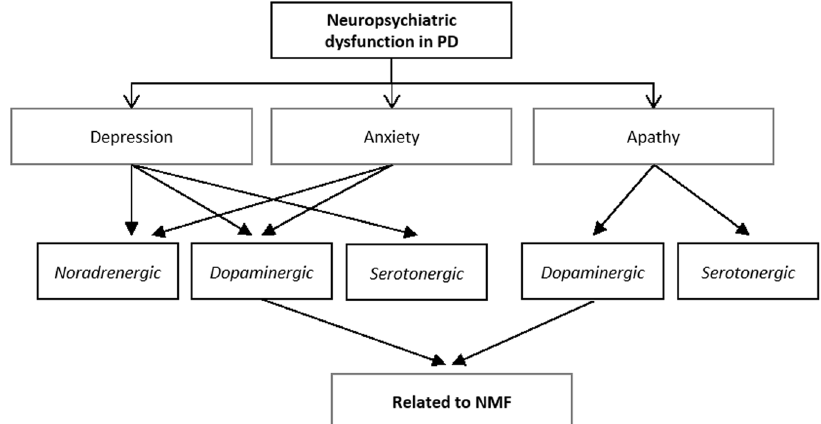
Fig. 3 Summary of neuropsychiatric dysfunction in PD and the possible pathway ’ s involved in their pathophysiology. PD Parkinson ’ s disease, NMF non-motor fl